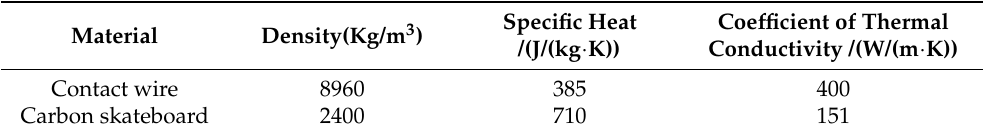
Table 1. Contact line with carbon slide parameters.